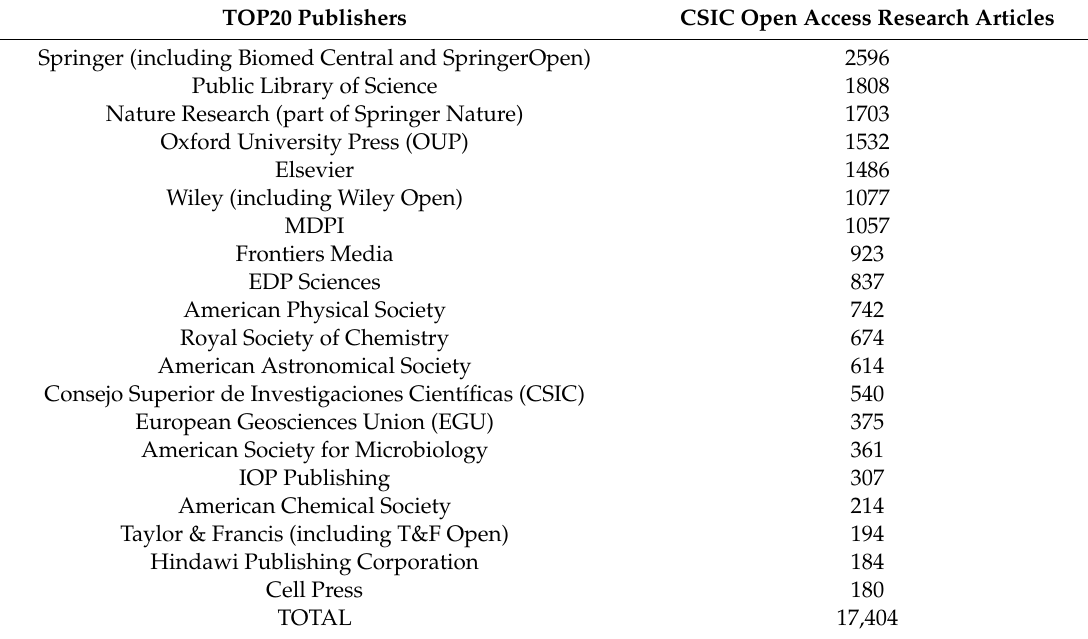
Table 3. CSIC Research Articles published in Open Access 2014–2018: TOP20